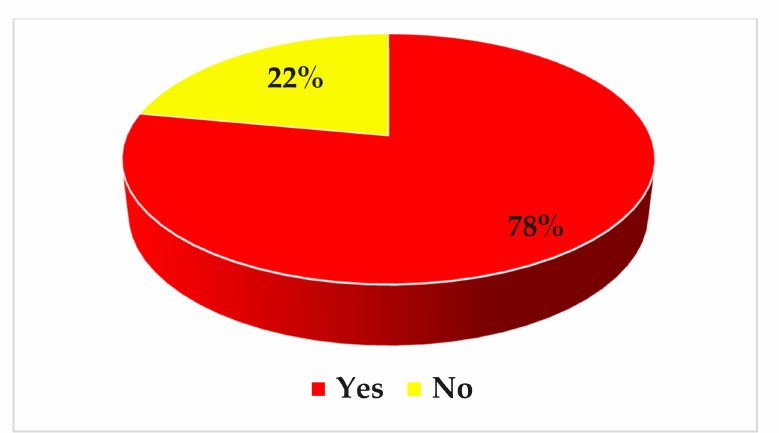
Figure 8. Characteristics of respondents based on social media